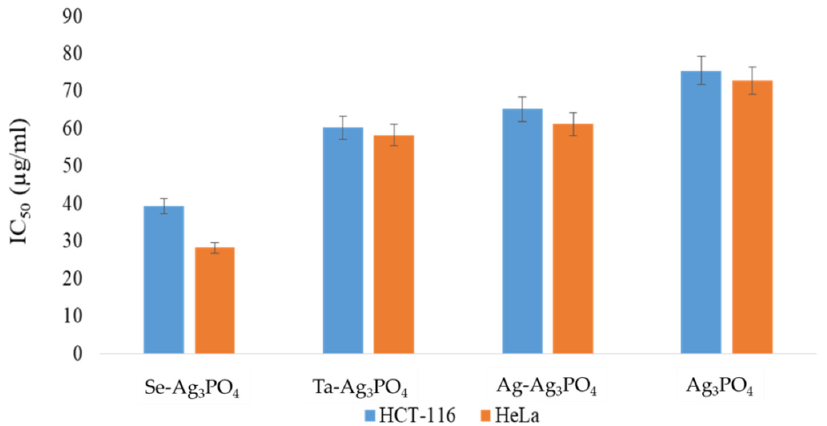
Figure 11. Average inhibitory concentration 50 (IC 50 ) of Ag 3 PO 4, Se-Ag 3 PO 4, Ag-Ag 3 PO 4, Ta-Ag 3 PO 4 on HCT-116 and HeLa cell. It shows the impact of treatment of Ag 3 PO 4, Se-Ag 3 PO 4, Ag-Ag 3 PO 4 , and Ta-Ag 3 PO 4 on HCT-116 and HeLa cells post 48 h treatment. The inhibitory concentration (IC 50 ) of Ag 3 PO 4, Se-Ag 3 PO 4, Ag-Ag 3 PO 4, and Ta-Ag 3 PO 4 was computed. The IC 50 values for Ag 3 PO 4, Se-Ag 3 PO 4, Ag-Ag 3 PO 4, Ta-Ag 3 PO 4 on HCT-116 cells were 39.44, 28.33, 60.24, 58.34 µ g/mL; whereas for HeLa cells, they were 65.25, 61.27, 75.52, 72.82 µ g/mL, respectively (Figure